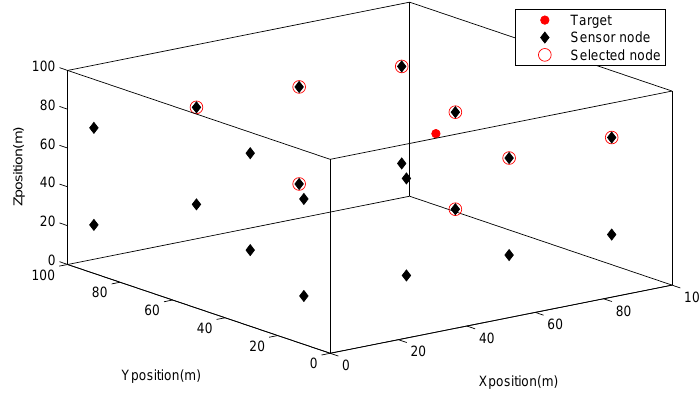
Figure 3. The selected sensor nodes in communication-constrained underwater acoustic sensor